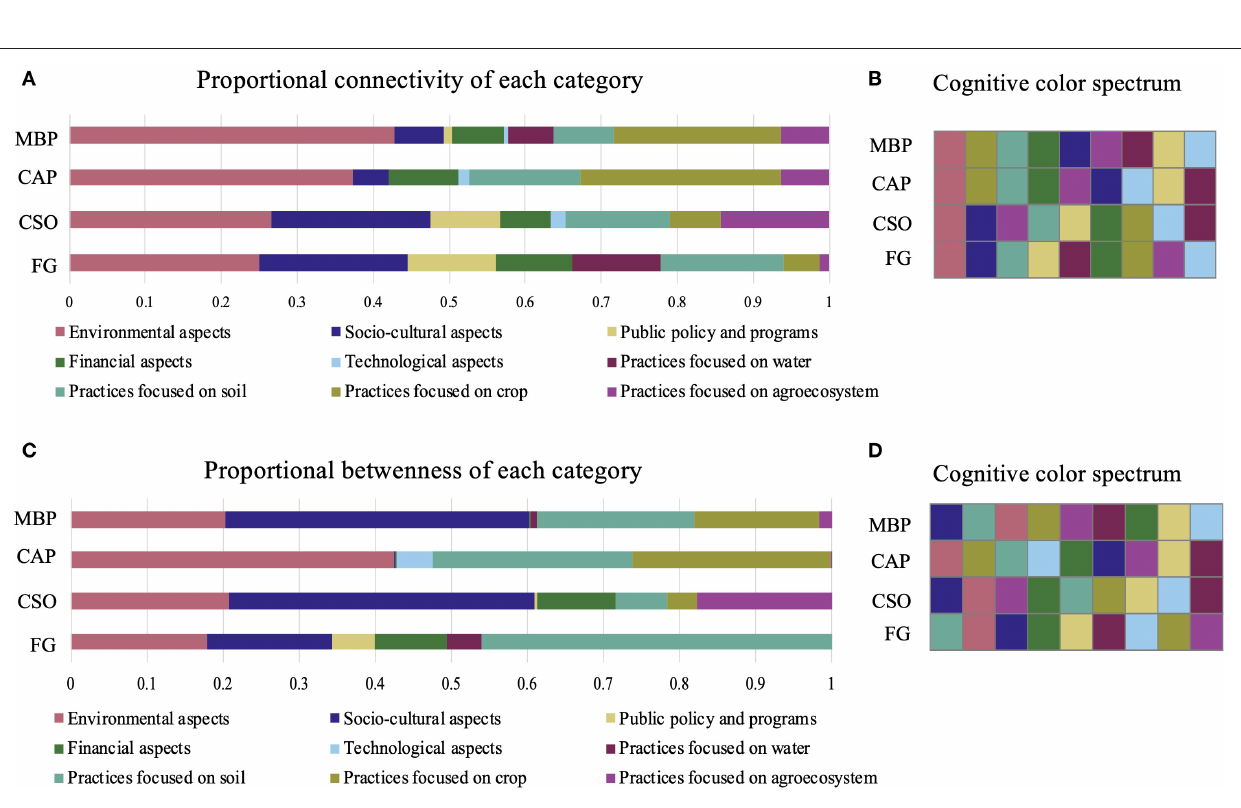
FIGURE 9 | Proportional centrality for each category for the sum of connectivity (A) and the sum of betweenness (C) per network as well as the Cognitive color spectrum charts of the four networks based on connectivity (B) and betweenness (D) .